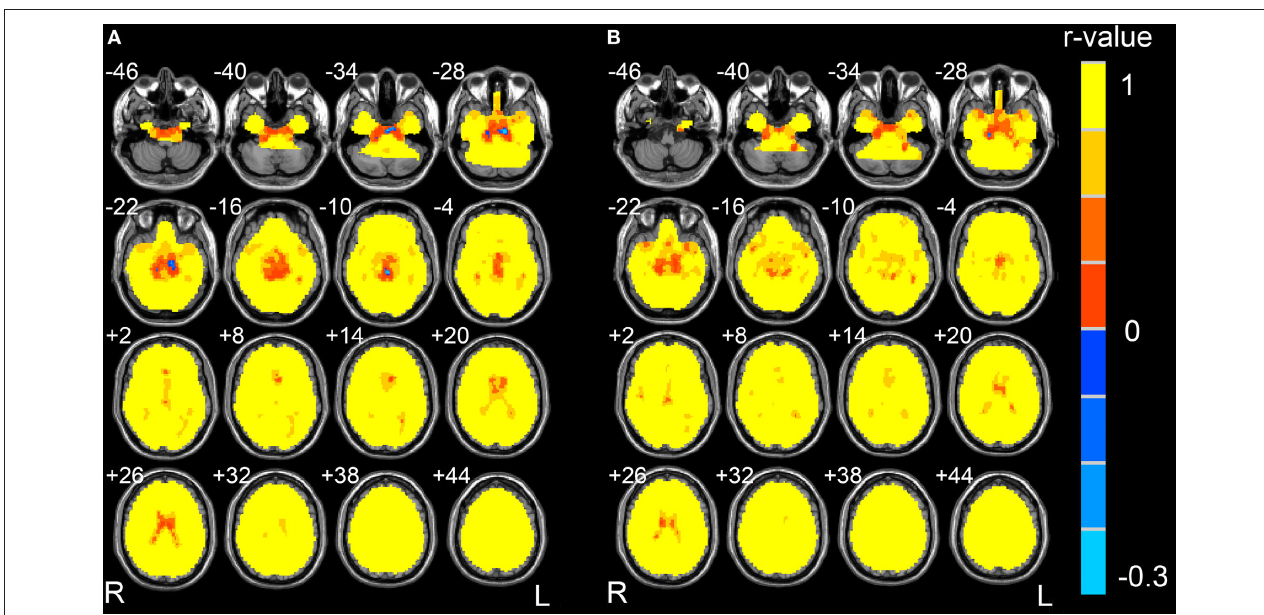
FIguRe 2 | Correlation map between Cohe-ReHo and KCC-ReHo of Dataset-1 (A) and Dataset-2 (B), respectively. The left side of the image corresponds to the right side of brain.